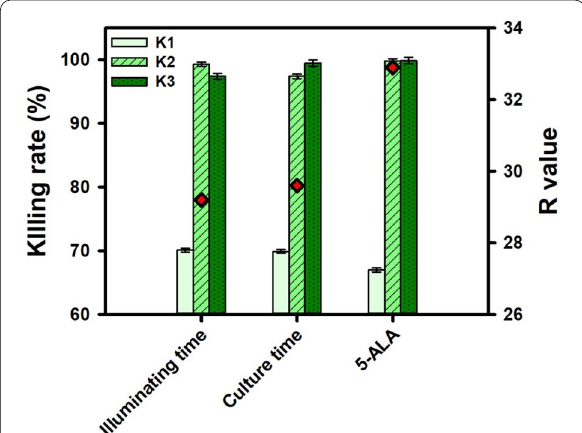
Fig.4 Taguchi L9 experimental results for 5‑ALA aPDT against the pathogen of Proteus hauseri. K1, K2 and K3 mean the average of killing rate for 3 levels of each parameter. The three levels of each factor: illuminating time (15, 30, 45 min); culture time (2, 3, 4 h); 5‑ALA concentration (1%, 2%, 3%). R is the divergence which is indicated by red